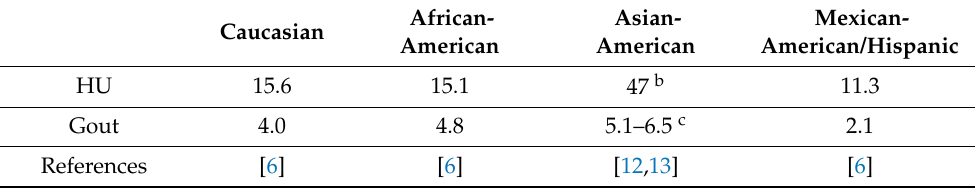
Table 6. Prevalence (%) of hyperuricemia and gout across U.S. populations a . Caucasian